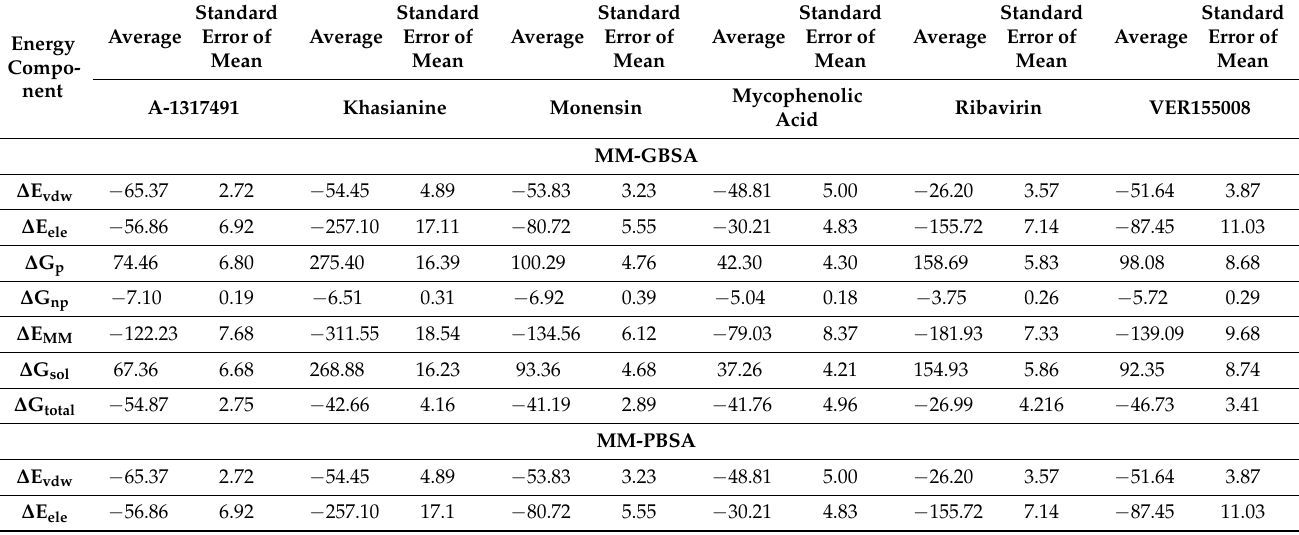
Table 3. Binding free energy of docked complexes. The energy values are given in kcal/mol